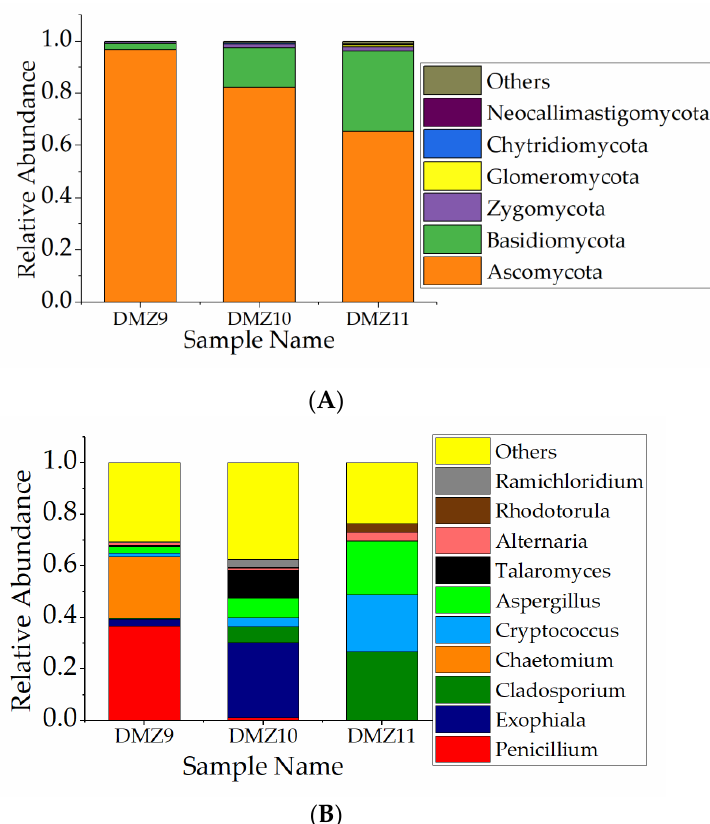
Figure 2. Fungal community analysis by high-throughput sequencing. Distribution patterns of fungal phyla and relative abundances of the fungal genera among samples ( A ); relative abundances of the fungal genera among samples ( B ).